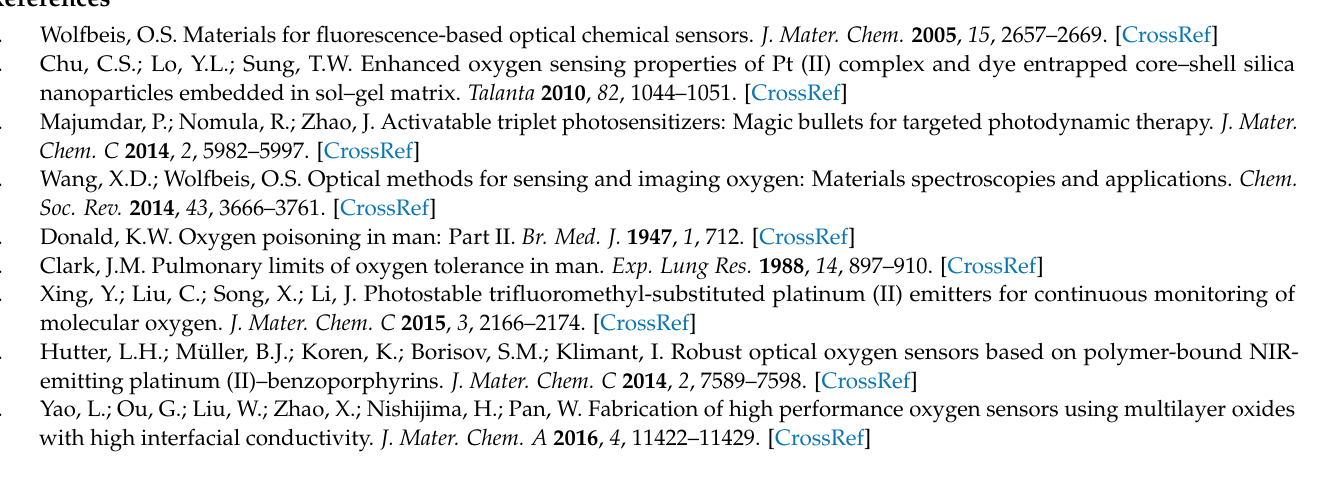
setup; Figure S1: (a) Emission spectra of the PtTFPP molecule on glass substrate with different oxygen concentrations from 0–100%. (b) Enlarged spectra from Figure (a) for better visualization; Figure S2: Gaussian fitting of a typical spectrum (PtTFPP molecules on an AAO membranes at 0% O 2 ) to extract actual peak intensities; Figure S3: (a) Phosphorescent spectra of the PtOEP molecule on glass substrate with increasing steps of oxygen concentrations from 0–100%. (b) Enlarged spectra from Figure (a) for better visualization; Figure S4: (a) Cross-sectional SEM image of the AAO nano-channels filled with PtOEP molecule. (b) EDS spectra revealing Al, O, C, Pt, and P peak separately. (c) EDS mapping on the area marked by the red square in Figure (a); Figure S5: (a) Dynamic response of PtTFPP oxygen sensor on glass substrate with gradual change in O 2 concentrations. (b) Zoomed-in plot of Figure (a) to estimate the response and recovery time; Figure S6: (a) Dynamic response of PtOEP oxygen sensor on glass substrate with systematically modified O 2 concentrations. (b) Zoomed-in plot of Figure (a) to estimate the response and recovery time; Figure S7: Photostability data of the oxygen sensors (PtTFPP and PtOEP) on glass substrate under one-hour continuous illumination; Figure S8: Response of the PtTFPP sensor fabricated on (a) AAO and (b) glass substrates at different relative humidity—low (RH 55%) and high (RH 75%); Figure S9: Response of the PtOEP sensor fabricated on (a) AAO and (b) glass substrates at different relative humidity—low (RH 55%) and high (RH 75%); Figure S10: S-V plots comparing the responses (PtTFPP) from the AAO substrates with different pore diameters (200 nm, 100 nm, 20 nm) with that of the glass substrate; Figure S11: Snapshots demonstrating dye molecules oozing out of the